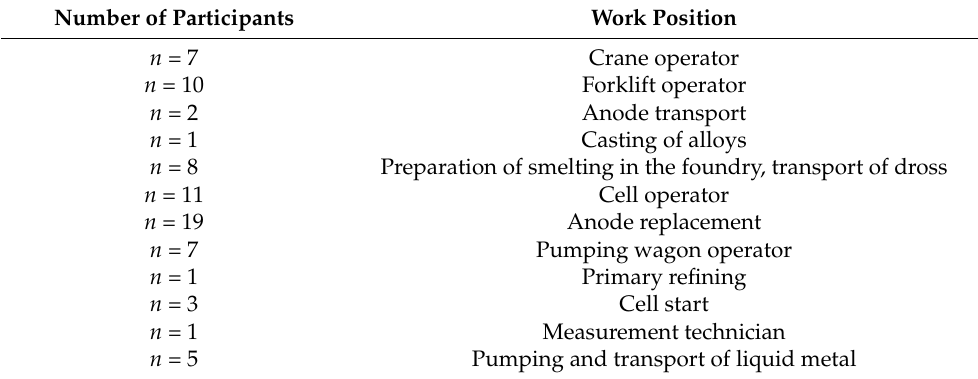
Table 1. Monitored work positions in primary aluminum